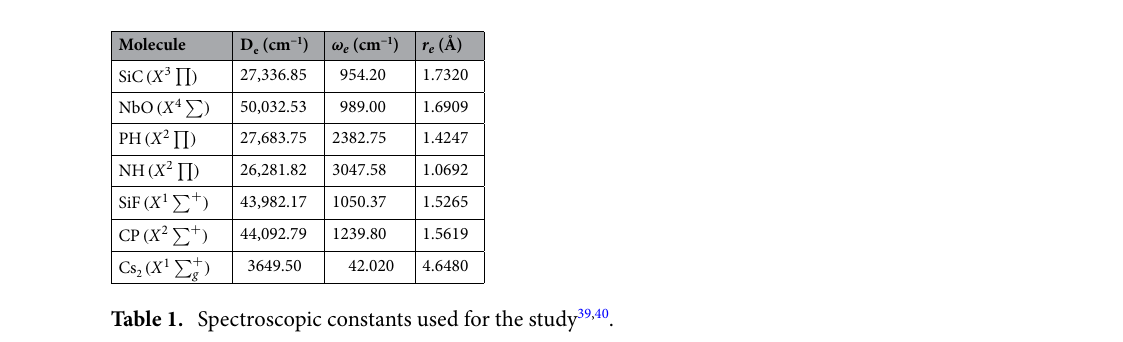
Figure 1. Shifted Morse potential and Morse potential with α = 0.35 cm −1 r e = 0.75 Å, D e = 20 cm −1 γ = 0.3, β = 0.65, and ℓ = 0.35 .